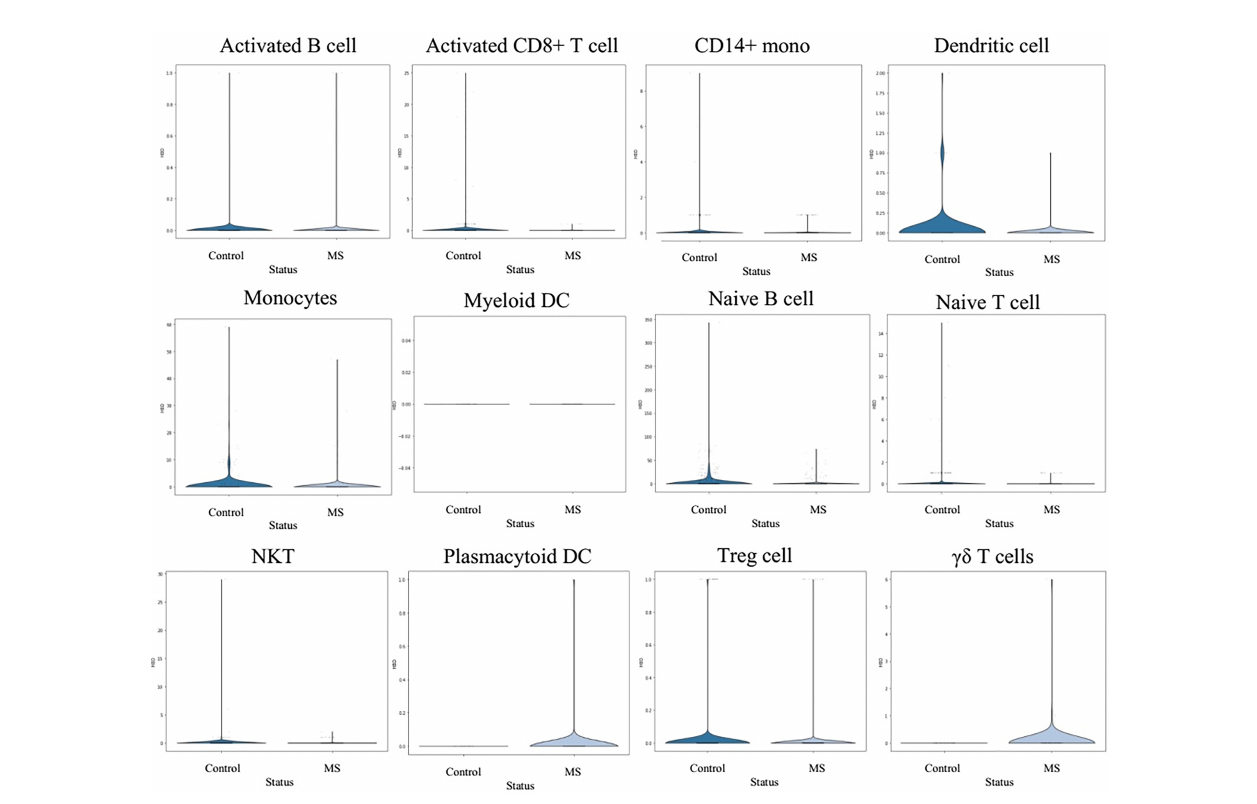
FIGURE 8 | Expression behaviour of HBD gene in different Louvain cluster.